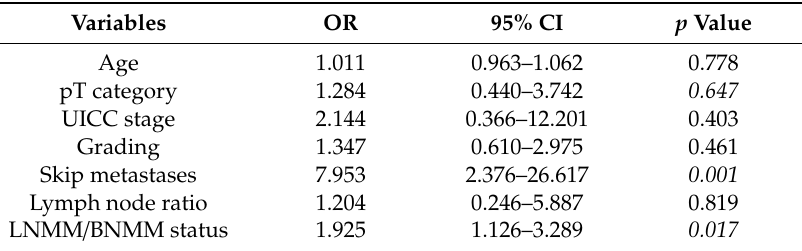
Figure 3. Kaplan–Meier curves of the presence of skip metastases and lymph node ratio for overall and recurrence-free survival. ( A ) Kaplan–Meier curves of the presence of skip metastases for overall and recurrence-free survival. ( B ) Kaplan–Meier curves of the lymph node ratio for overall and recurrence-free survival. The crosses mark censored patients. p value < 0.05 is considered significant. Table 3. Multivariate analysis for overall